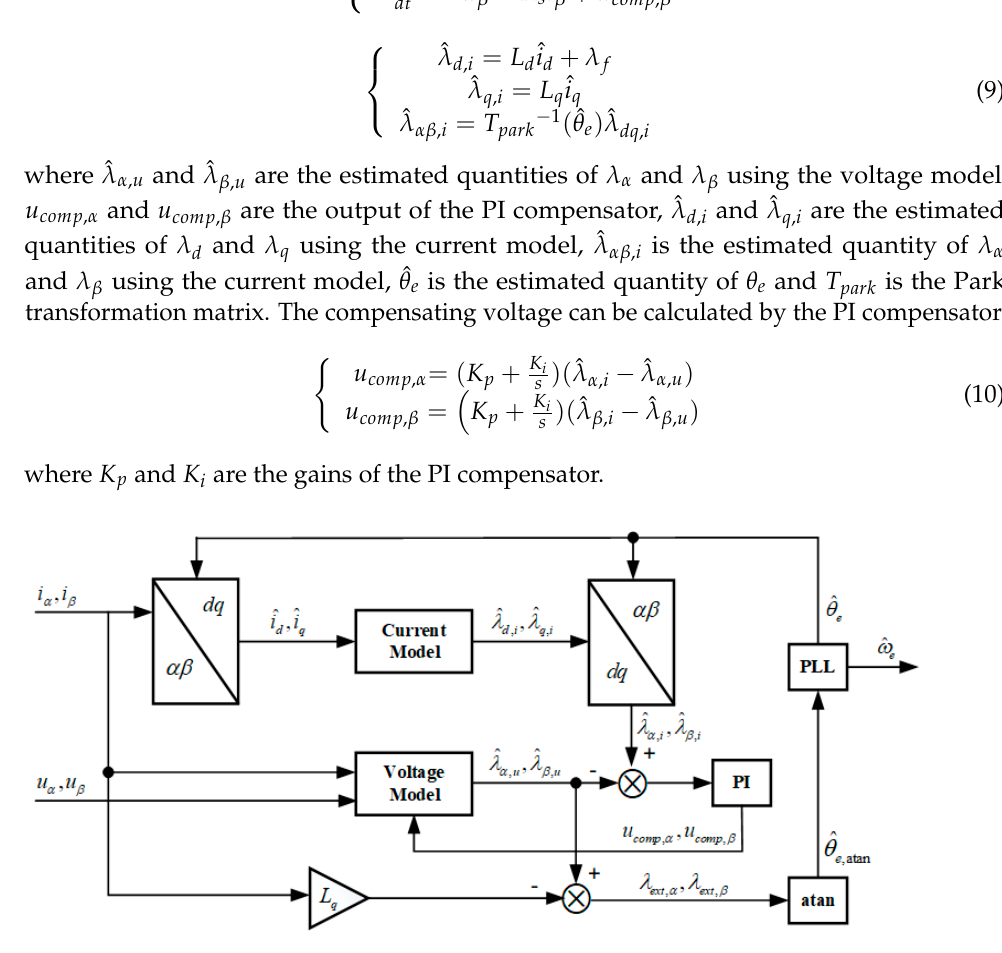
( b ) Figure 4. Comparison of the three mainstream rotor position estimation methods: ( a ) Speed estimation results over full speed range; ( b ) Rotor position estimation error over full speed range.